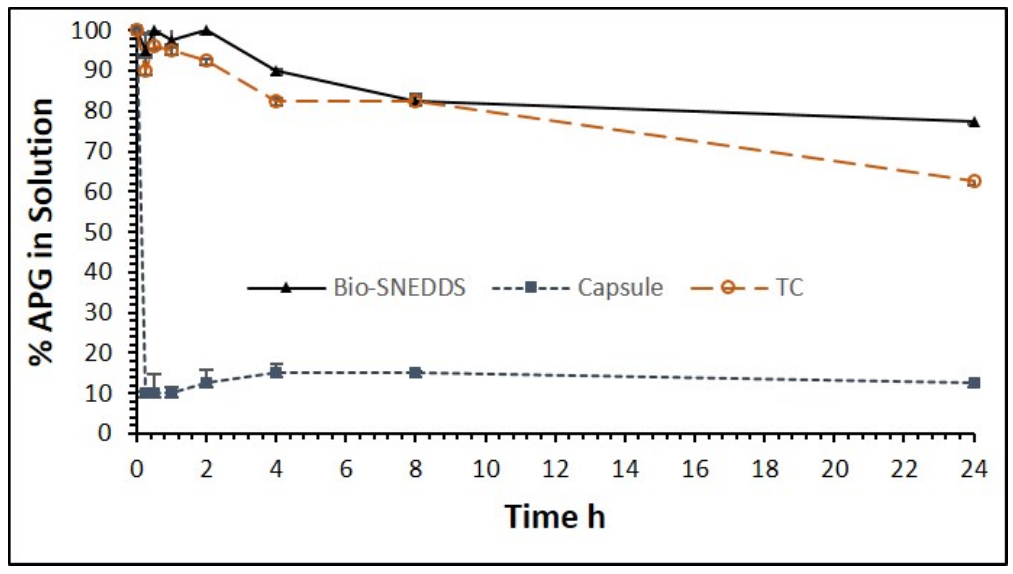
Figure 7. The percentage of apigenin in the solution over 24 h after 1:100 dilution in the aqueous media (fed state intestinal fluid—FeSSIF). Formulations studied: the Bio-SNEDDS F11 (CoFA: CMCM: TC (3:1:1)/HCO30 [1/1]), the commercial APG capsule and F14 (TC only formulation). Data are presented as mean ± SD, ( n = 3).